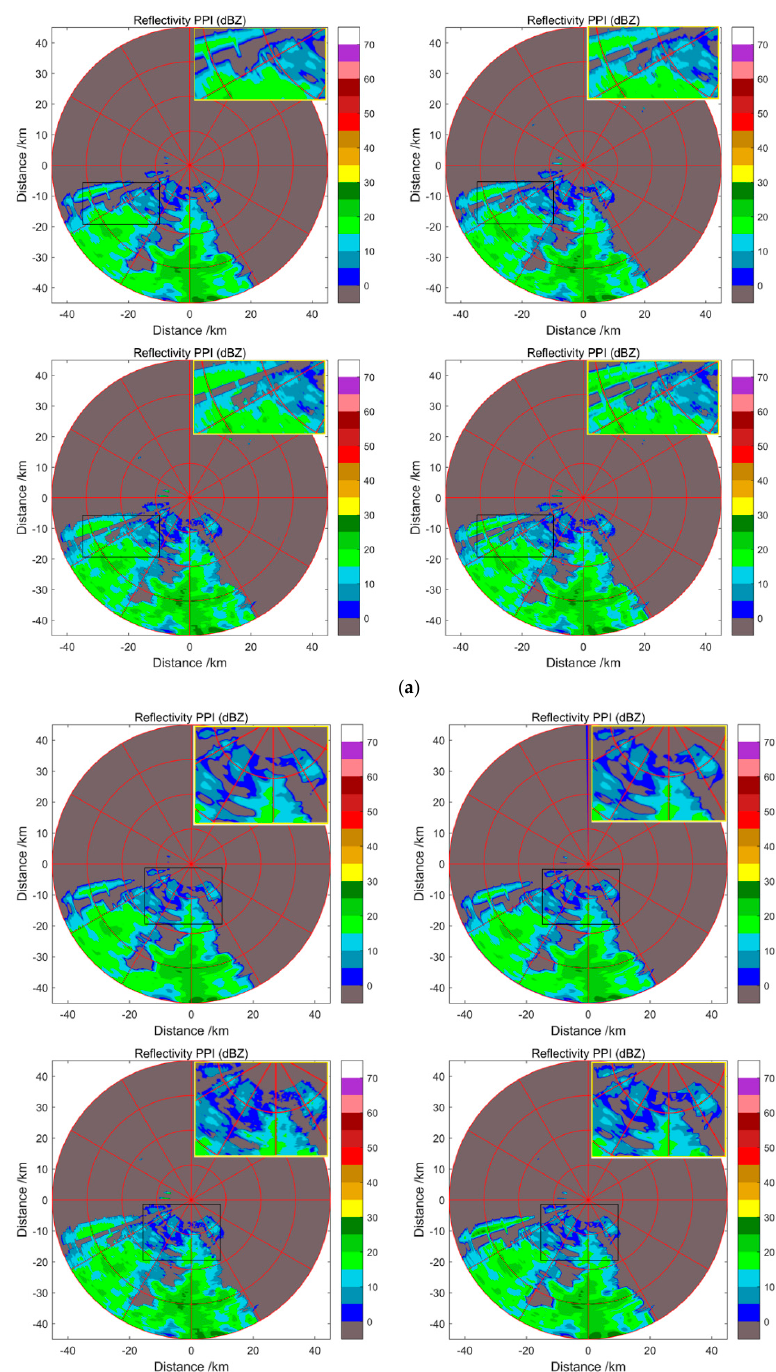
Figure 7. Radar echo reconstruction comparison on reflectivity data. ( a ) 2 × reconstruction of reflectivity data. From left to right and top to bottom: bicubic interpolation echo, the reconstructed echo by IBP [13] (PSNR = 39.1936; SSIM = 0.9867), original radar echo, and the reconstructed echo by the proposed NSSR algorithm (PSNR = 41.9943; SSIM = 0.9877). ( b ) 4 × reconstruction of reflectivity data. From left to right and top to bottom: bicubic interpolation echo, the reconstructed echo by IBP [13] (PSNR = 32.9533; SSIM = 0.9221), original radar echo, and the reconstructed echo by the proposed NSSR algorithm (PSNR = 37.1748; SSIM = 0.9588). The tested data is the first elevation cut of the XPRAD at 10:43 (BJT) on 28 May